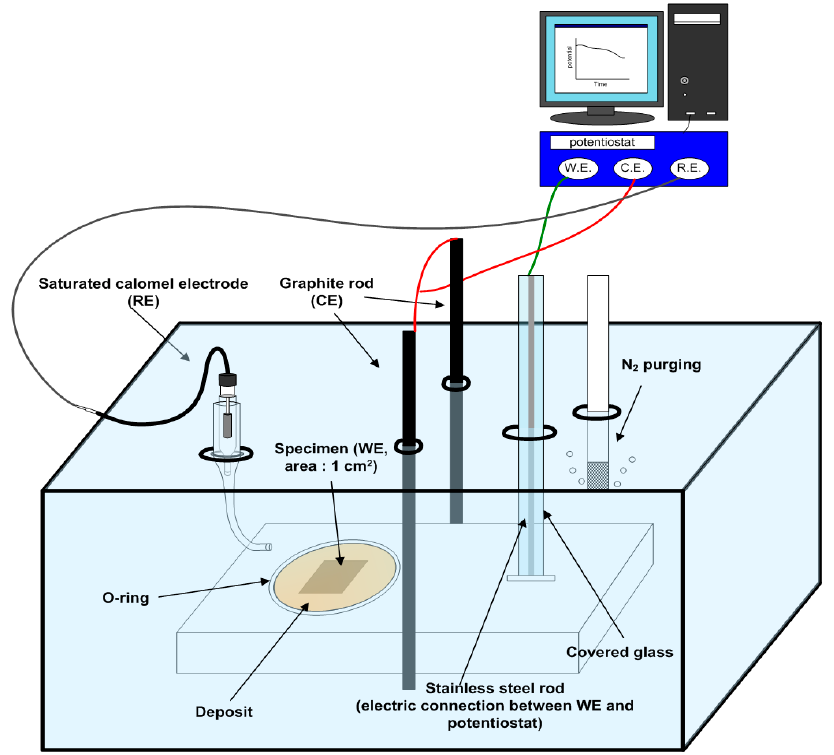
Figure 2. Schematic of three-electrode electrochemical cell used in this study.